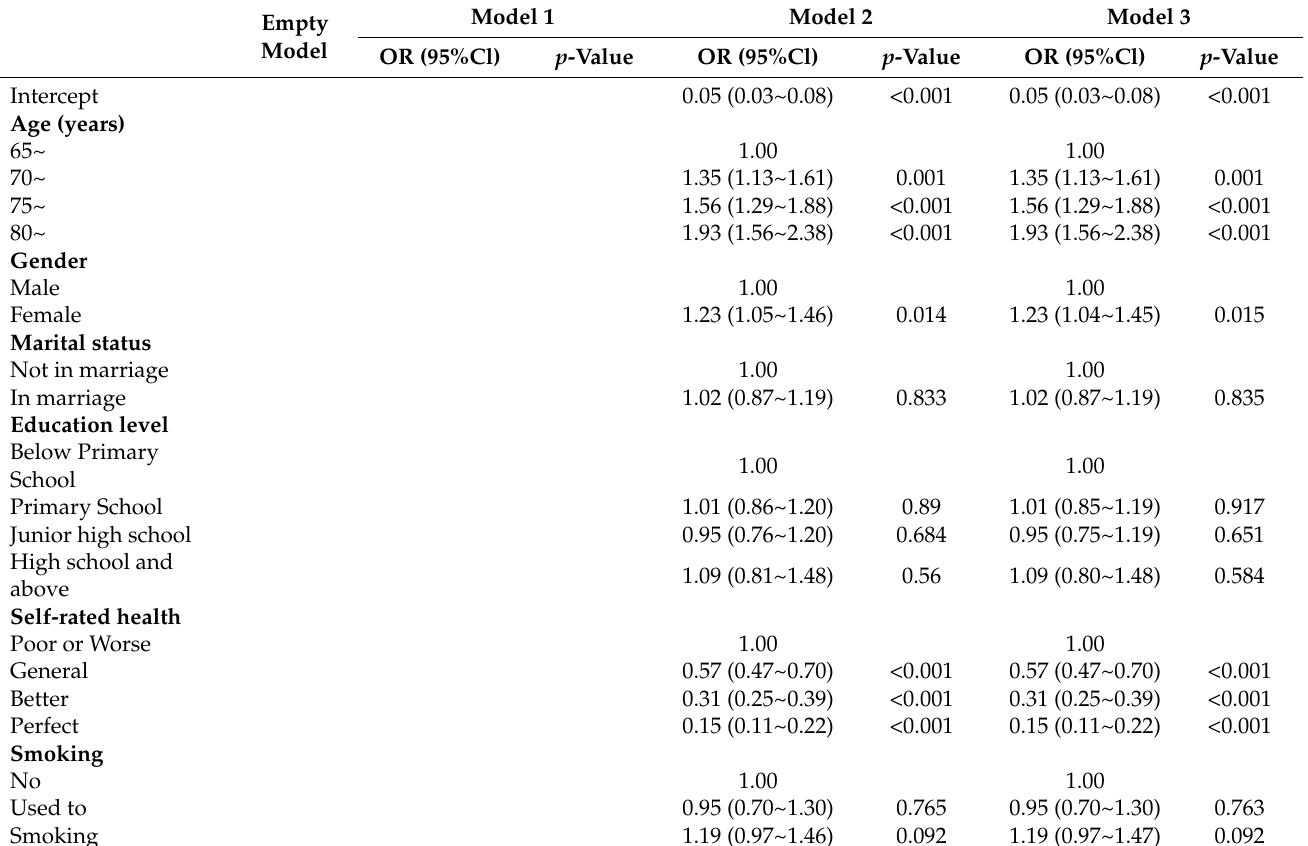
Table 2. Multilevel results predicting frailty by individual-level and community-level